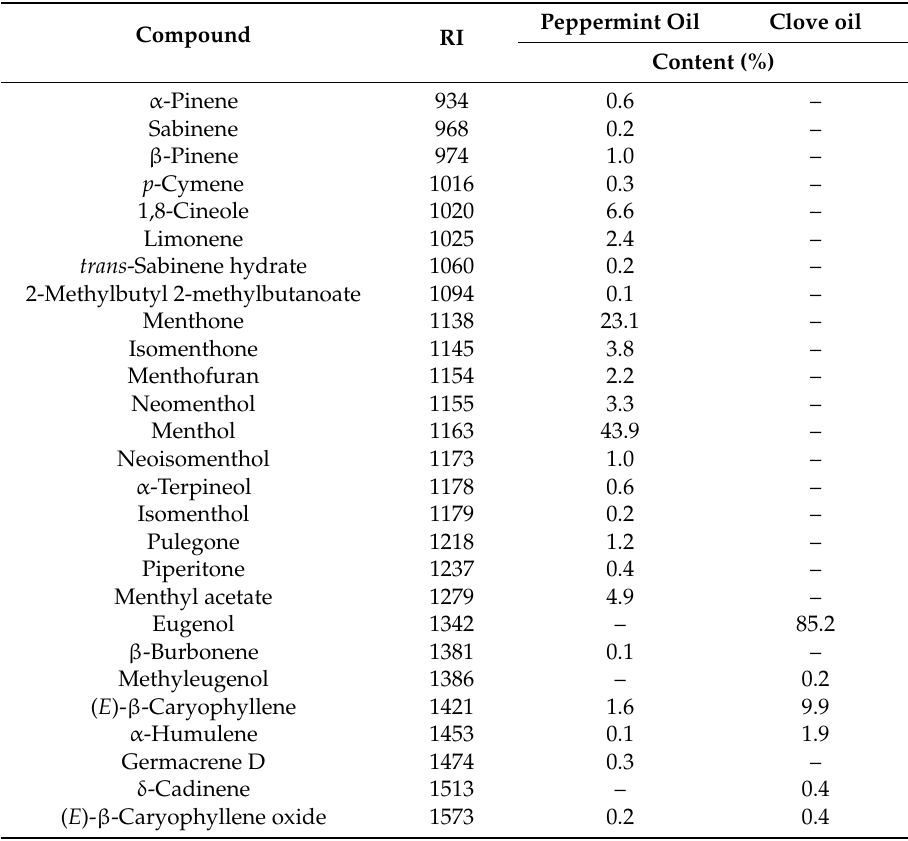
Table 3. Composition of essential oils (GC-MS analysis); RI: retention index, —: not detected.